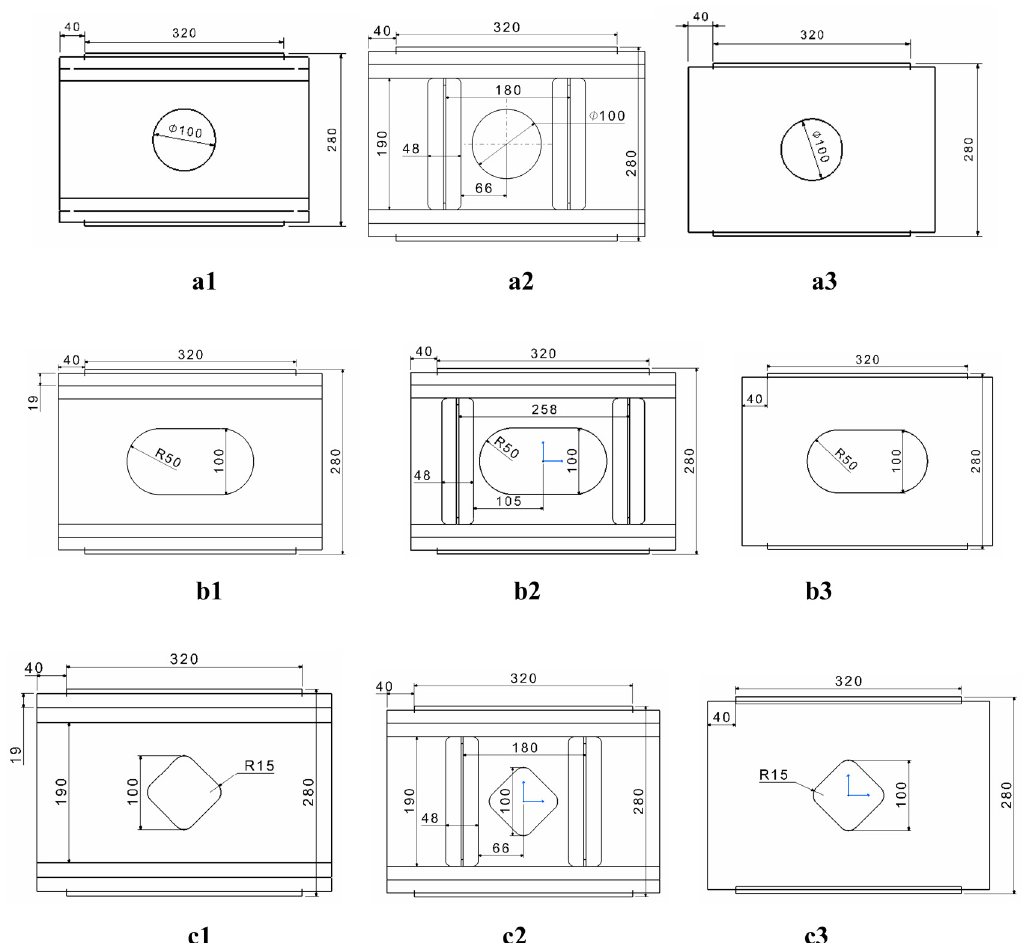
Figure 2: Samples for the experiments. a1, b1, and c1: samples with circular, oblong, and rhombic openings; a2, b2, and c2: those reinforced by ribs; a3, b3, and c3: those reinforced by thickening the web. In sub - fi gures a2, b2, and c2 of Figure 2, the dimensions and the positions of the ribs used for reinforcement are shown in detail.